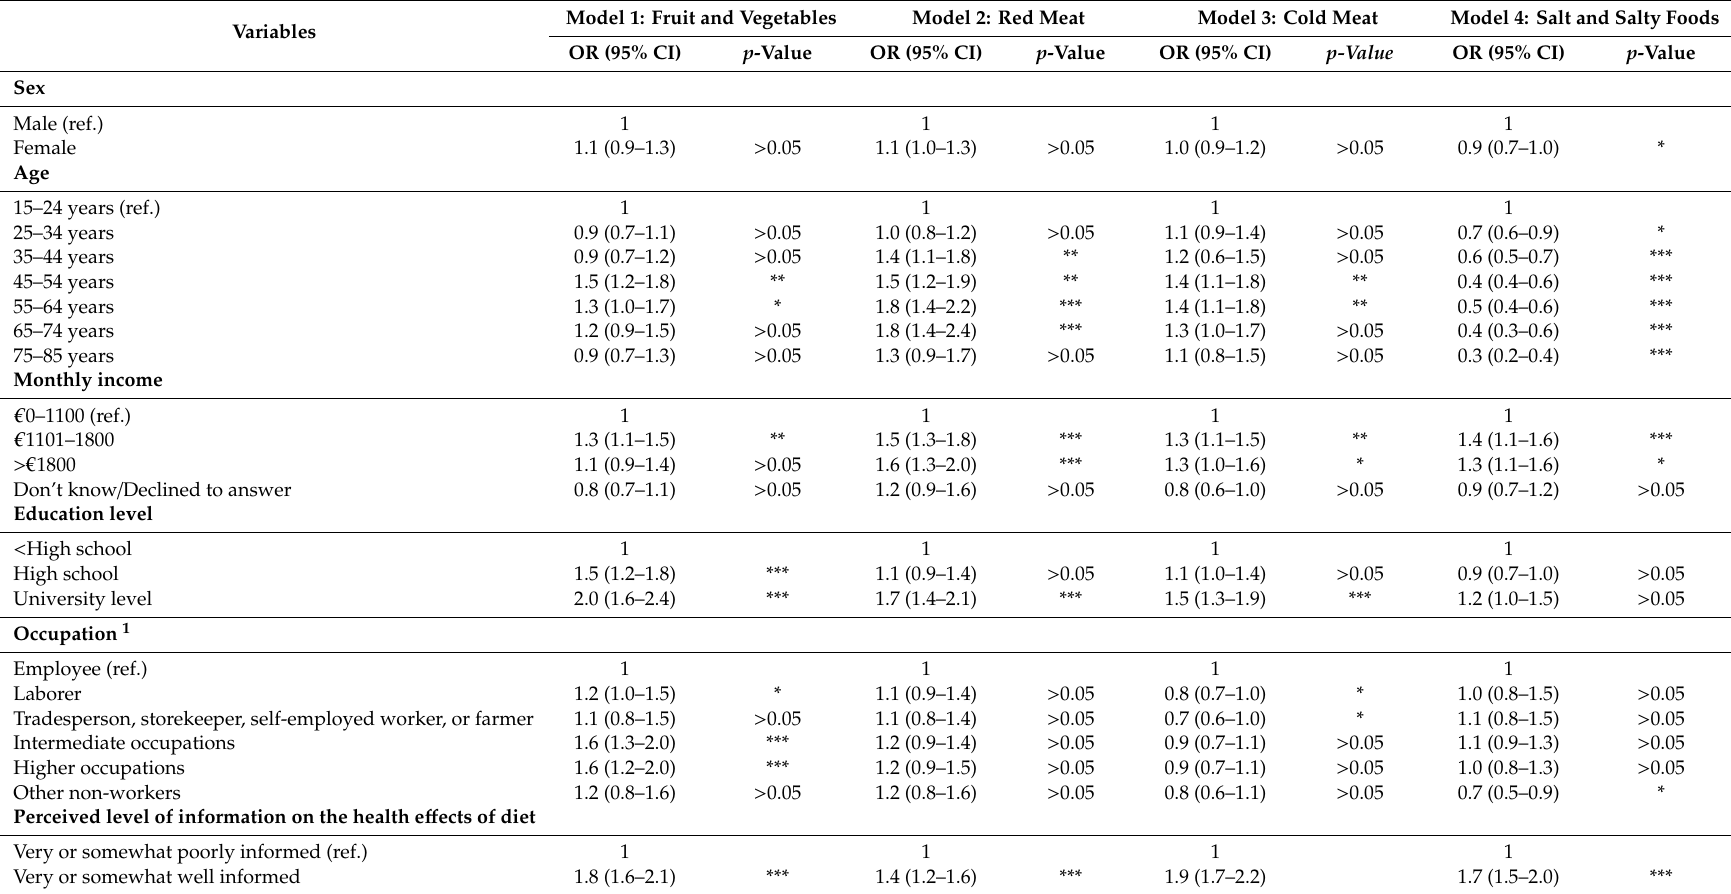
Table 5. Sociodemographic factors associated with perception of the role of food in cancer risk ( n = 3762). Model 1: Fruit and Variables